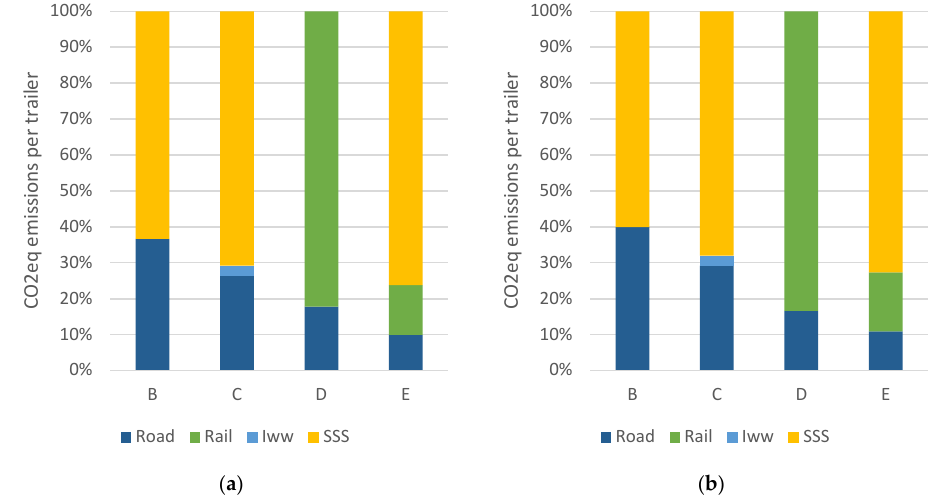
Figure 4. Share of CO 2 ‐ eq emissions per transport mode: ( a ) scenario 1; ( b ) scenario 2.